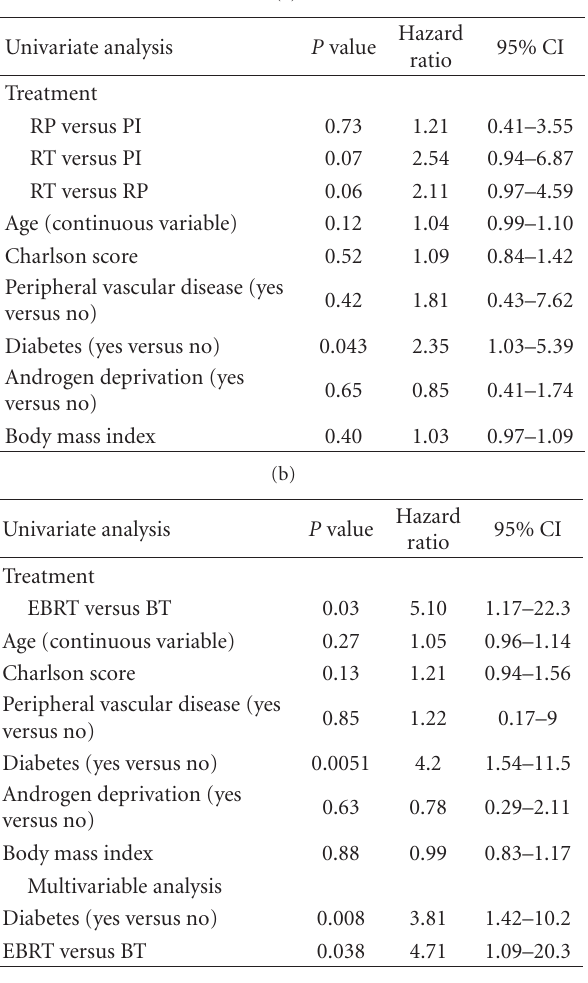
Table 3: (a) Competing risk regression for late GU toxicity ( ≥ 2) for patients treated in 1999. (b) Competing risk regression for late GI toxicity ( ≥ 2) for patients treated with RT or PI in 1999 ( n =